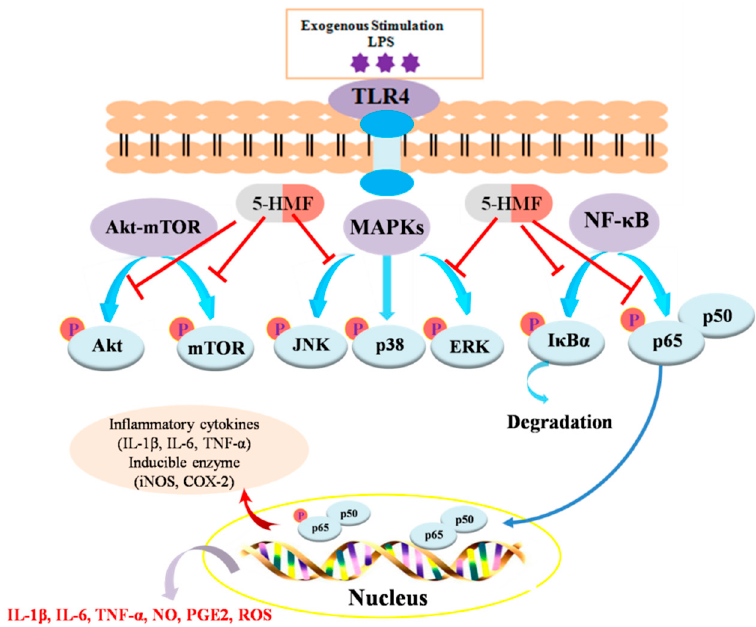
Figure 8. Suggested anti-inflammatory mechanisms of 5-HMF in LPS-stimulated macrophages.